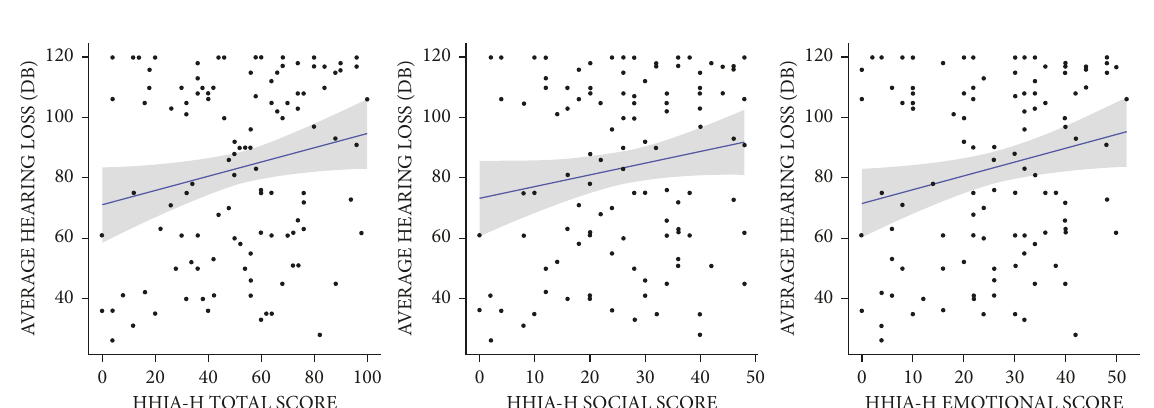
Figure 1: Scatter plot showing correlation between HHIAH scores, subscores, and average hearing